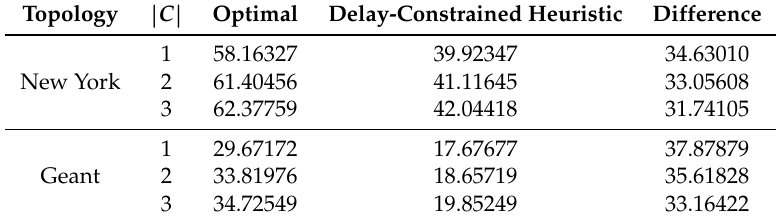
Table 4. Energy savings with paths’ delay constrained to r =